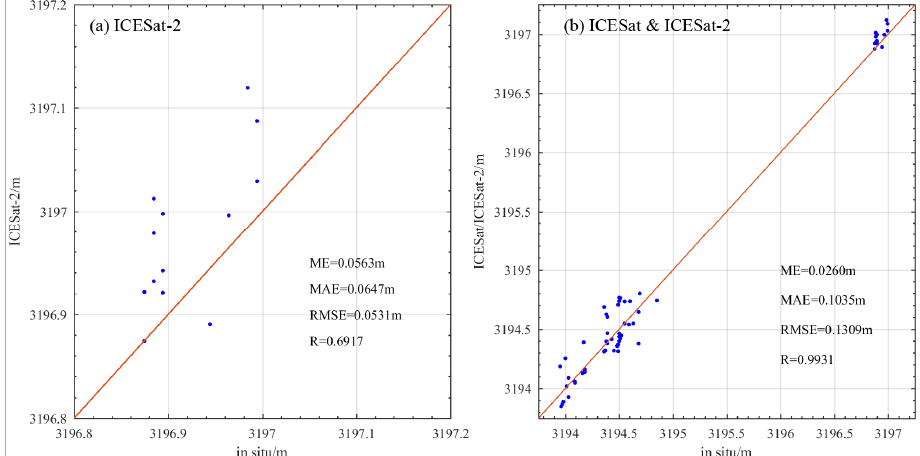
Figure 10. The validation results of the ICESat/ICESat-2 using the in situ water